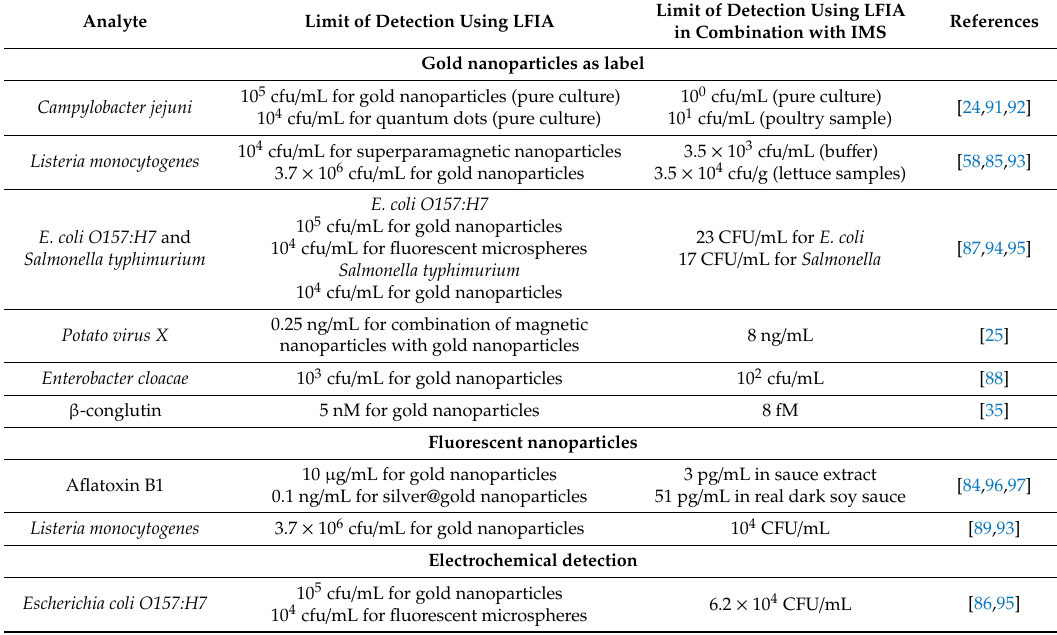
Table 6. Limit of detection improvements using